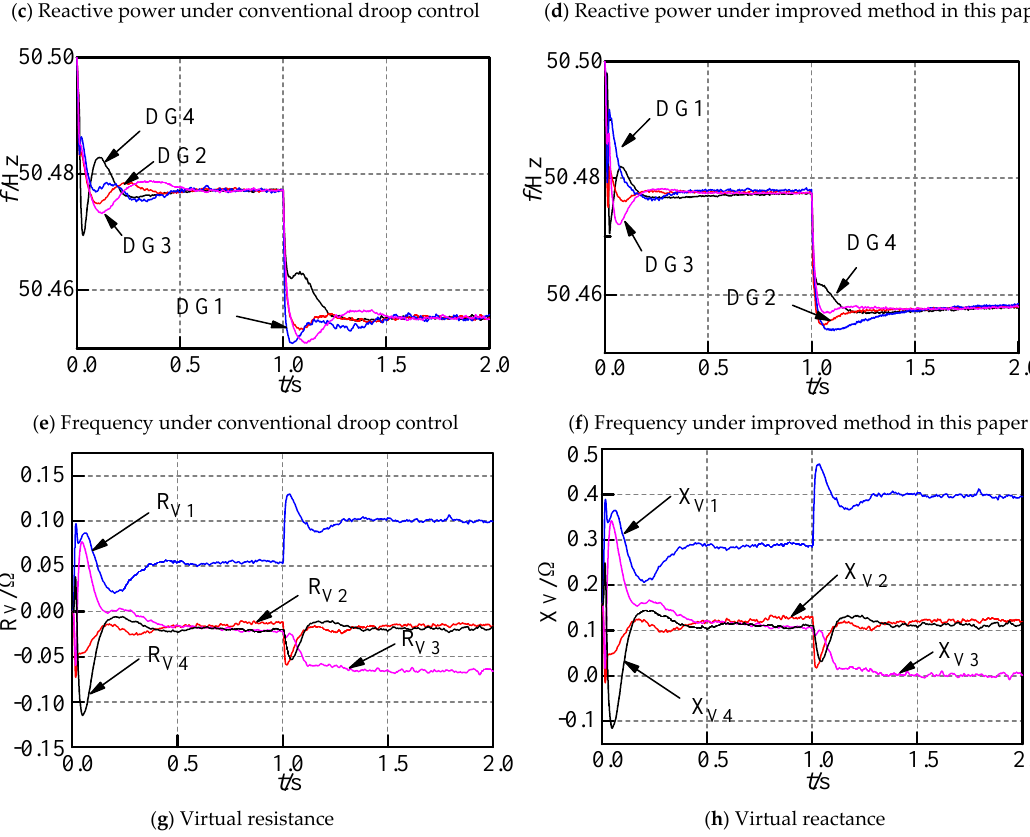
( b ) Reactive power Figure 13. Comparison of power waveforms. The voltage sag at the microgrid AC bus is shown in Figure 14. As the conventional droop control is deviation-based, voltage sags may occur, especially when a virtual impedance is added. Compared with the control method based on direct introduction of virtual impedance, the bus voltage sag caused by the adaptive virtual impedance control method proposed in this paper is low. 0.0 t /sConventional droop strategy Figure 14. Microgrid AC bus voltage.